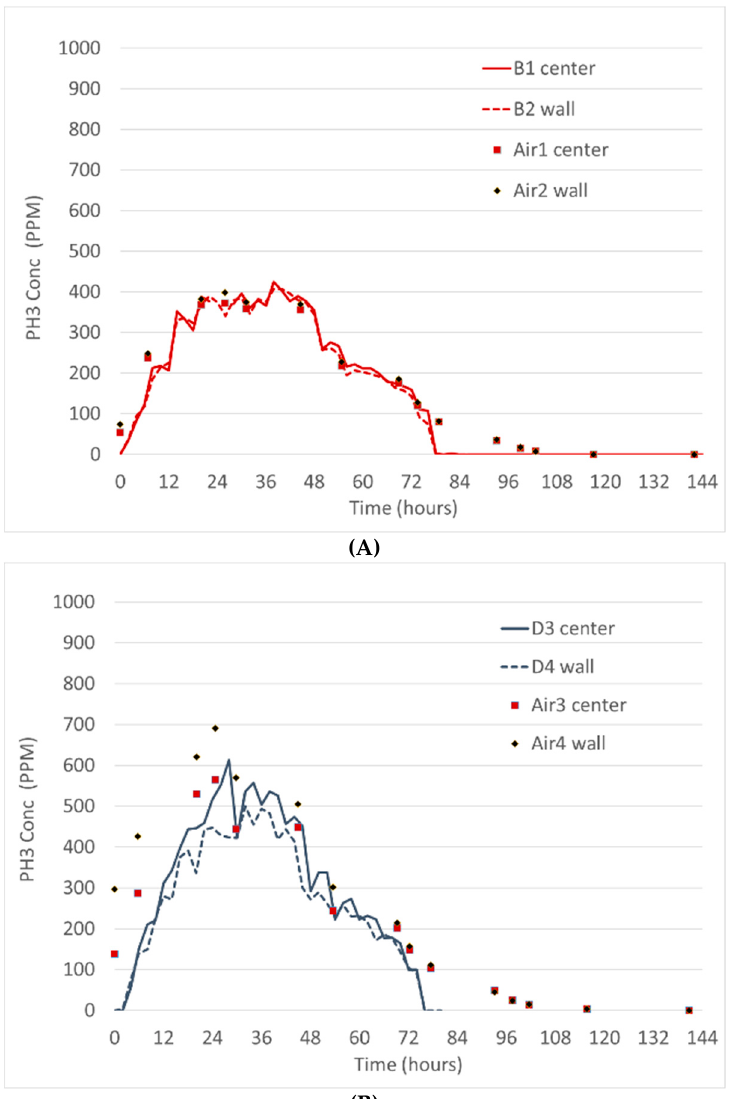
Figure 6. Fumigation Trial #2. ( A ) Bin B with 320 Phostoxin tablets distributed on the grain surface with a recirculating fan providing intermittent airflow. B1 and B2 are the wireless sensors while Air1 and Air2 are the airlines next to those sensors. ( B ) Bin D was prepared, treated, and monitored with the sensors and the airlines at the same time. D3 and D4 are the wireless sensors while Air3 and Air4 are the airlines next to them.